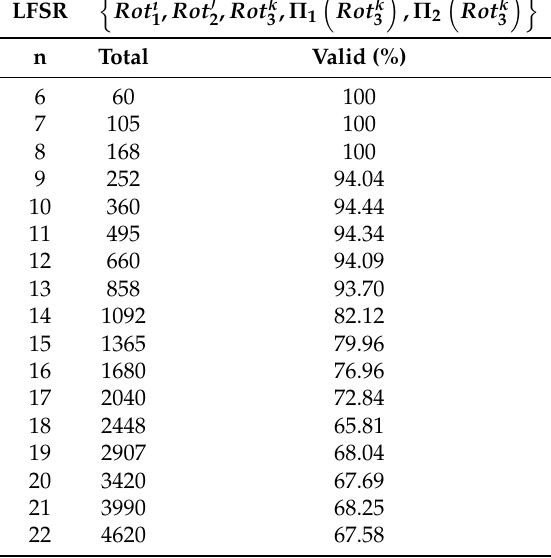
Table 5. Number of Valid Rotations for an acceptance minimum of level 95% where the proyections Π 1 and Π 2 have been